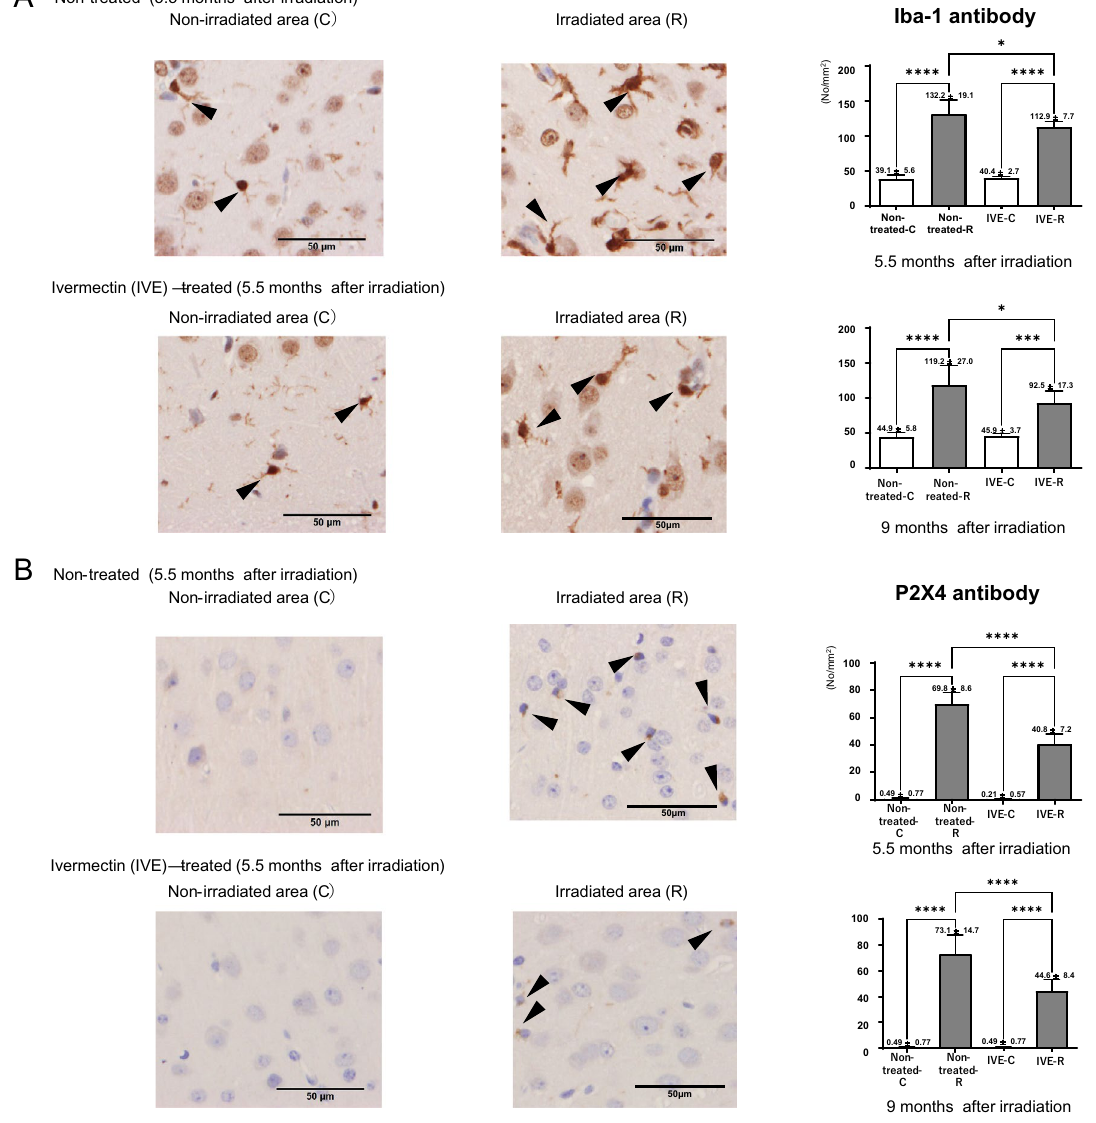
Figure 4. Immunostaining of Iba-1 and P2RX4 between non-treated and Ivermectin (IVE)-treated RN model mice. Histology of the non-irradiated (C) and irradiated (R) areas using ( A ) Iba-1 antibodies and ( B ) P2RX4 antibodies in the non-treated and IVE-treated brain radiation necrosis mice at 5.5 months after irradiation. Bar graphs indicate the numbers in each group (non-treated: n = 6 and IVE-treated: n = 7). The same is shown for mice at 9 months after irradiation (non-treated: n = 6 and IVE-treated: n = 6). Scale bar = 50 µm. *** P < 0.001, **** P < 0.0001 versus non-irradiated mice, * P < 0.05, **** P < 0.0001 versus non-treated mice, one-way analysis of variance. ( C ) Co-expression of Iba-1 (red) and P2RX4 (green) in the irradiated area at 5.5 months after irradiation. Bar graphs indicate the percentage of co-expression rates (%) (non-treated: n = 3 and IVE-treated: n = 3). * P < 0.05, unpaired t